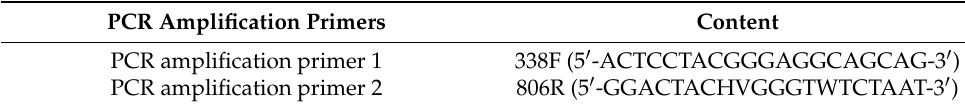
Table 2. PCR amplification